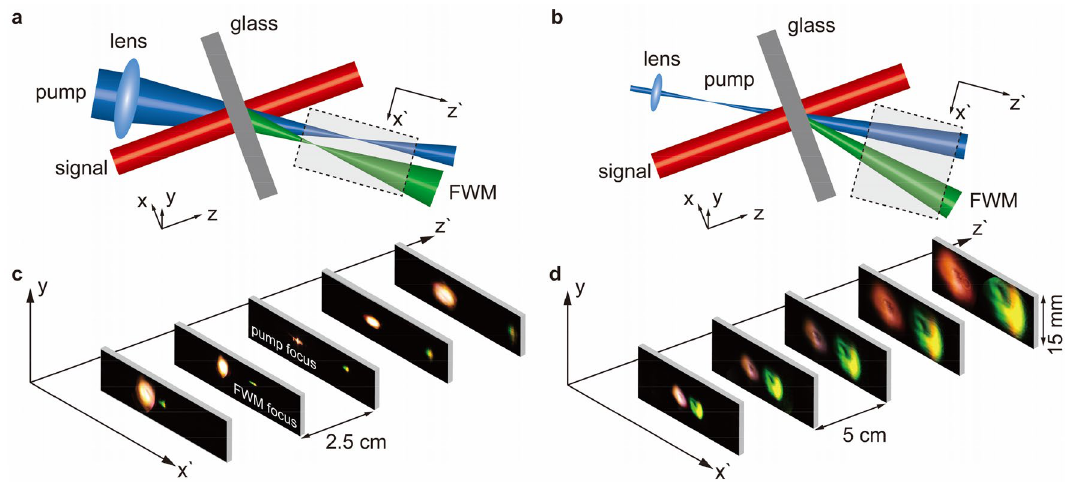
Figure 4. Beam evolution through a nonlinear flat slab in the transverse plane. ( a,b ) show the experimental schematics of a normal incident signal onto the flat slab with a converging ( a ) and a diverging ( b ) pump beam. A series of images ( c , d ) are taken within the shadowed area behind the flat slab. ( c ) A scan with a 2.5 cm increment from 10 to 20 cm after the glass slab along the path z` unveils the relevant beams’ transverse ( x` ~ y plane) evolution trends for the nonlinear flat lens scheme, showing a focusing FWM beam. Its focus is observed at around 12.5 cm when the pump’s focal point is placed at around 15 cm from the slab. In a contrast, ( d ) a similar scan reveals a diverging nature of the FWM beam behind the flat slab when the pump beam is diverging as well. The furthest FWM beam spot reaches a diameter of up to 15 mm at a distance of 27.5 cm, the nonuniform wavefront of the FWM beam may be caused by the nonuniform pump Figure 4c lists an array of images lining along the direction z` from the shadowed area of the setup in Fig. 4a. Images are taken from 10 to 20 cm after the glass slab along the path z` in a 2.5 cm increment. We use a camera with only a viewfinder (size: 23.6 × 15.8 mm) to capture the images in the x` ~ y plane (transverse plane). Since the viewfinder’s size is adequate for most situations, we can directly collect the wavefronts for either the pump or the FWM beam’s evolution trends. The red spots denote the pump and the green-yellow ones for the FWM beams. The results clearly show that with a converging pump’s wavefront, we can realize the generated FWM in